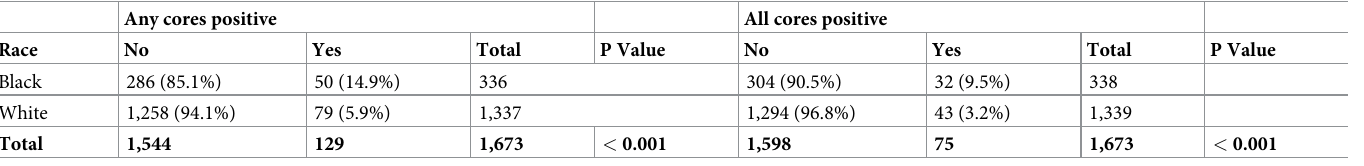
Table 2. GSTP1 protein staining in cancer cells in Black and White patients. Any cores positive All cores